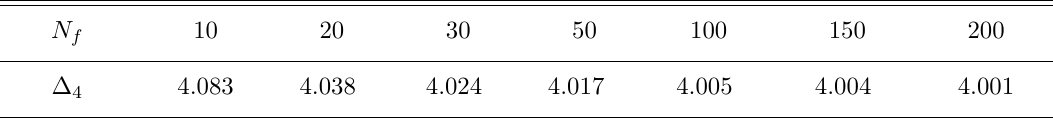
ad and we fix it at ∆ ∗ = 4 1 1